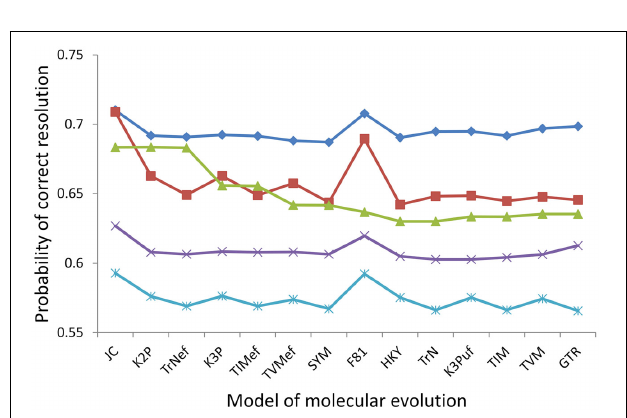
FIGURE 5 | Probabilities of correct resolution for the backbone node of the haploid Candida clade for RPB2 (diamond), ACT1 (square), COX2 (triangle), RPB1 (cross), and D1/D2 LSU (star) calculated for each of the the 14 alternative